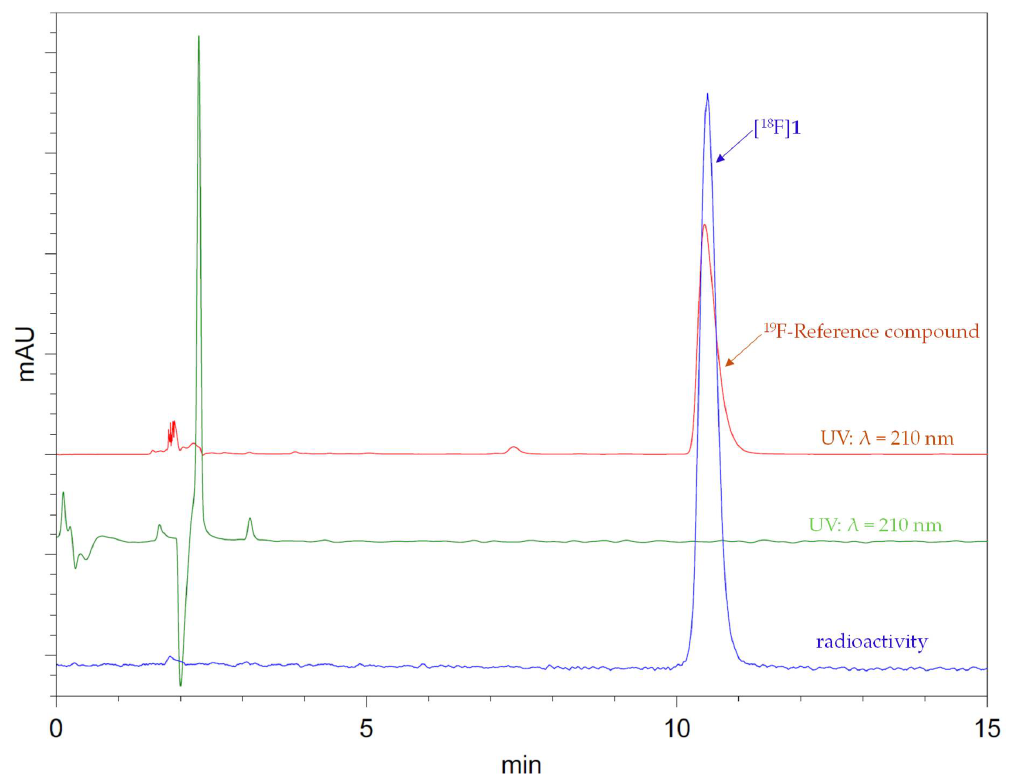
Figure 1. HPLC traces of the purified and formulated radiotracer [ 18 F] 1 , and the 19 F-reference compound 1 . Blue trace: [ 18 F] 1 (radioactivity channel); green trace: [ 18 F] 1 (UV channel, λ = 210 nm); red trace: 19 F-reference compound (UV channel, λ = 210 nm).